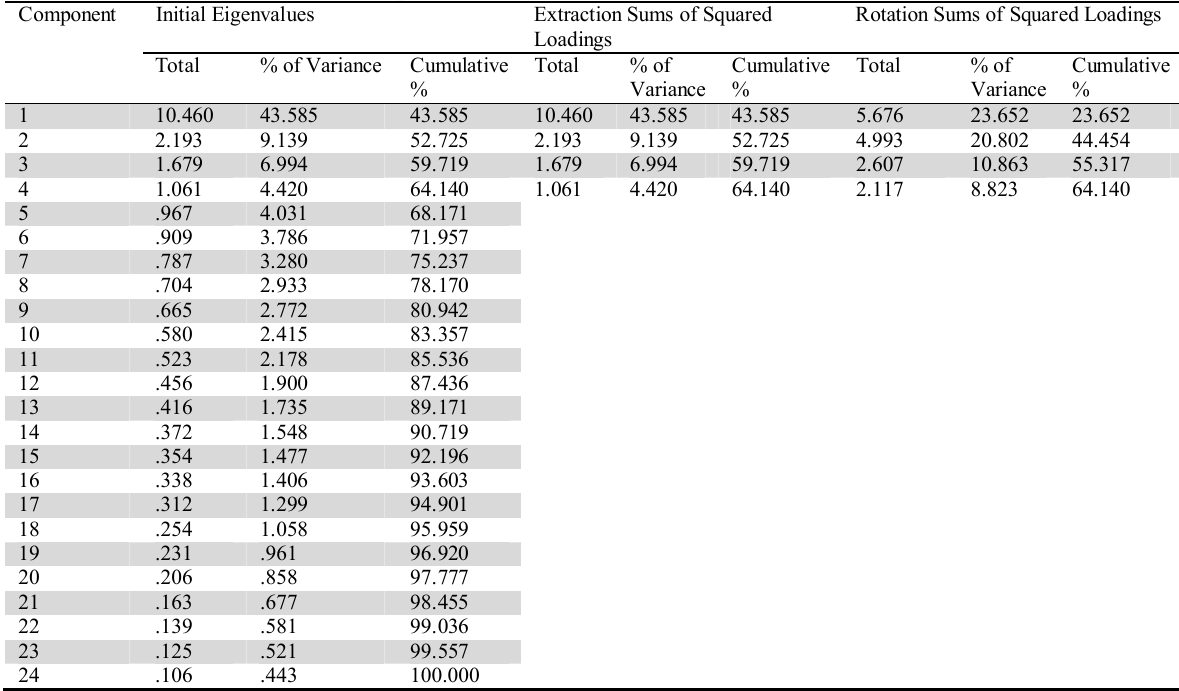
The summary of total variance explained Component Initial Eigenvalues Extraction Sums of Squared Total % of Variance Cumulative